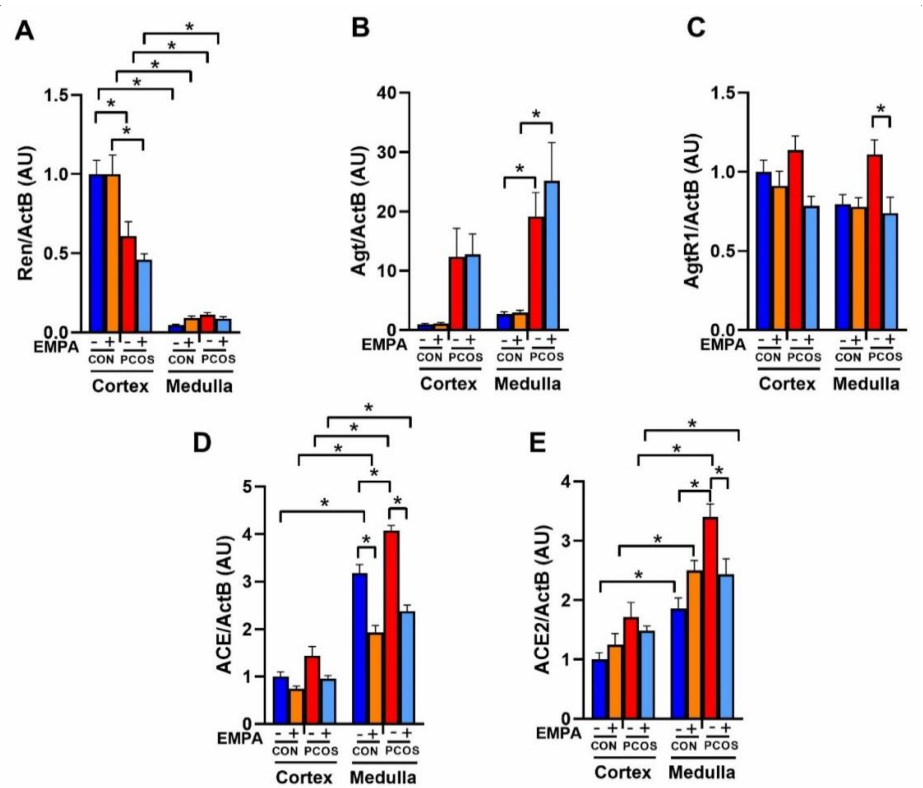
Figure 6. Effect of EMPA on mRNA expression of the intrarenal renin-angiotensin system in PCOS. Effect of EMPA on the renal cortical and medullar mRNA expression of ( A ) Ren (Renin), ( B ) Agt (Angiotensinogen), ( C ) AgtR1 (AT1R), and ( D ) ACE (angiotensin-converting enzyme), and ( E ) ACE2 (angiotensin-converting enzyme 2) after 3 weeks of EMPA treatment. Data are expressed as mean ± SEM. Data were analyzed by three-way ANOVA followed by Tukey post-hoc tests. Significant interaction was observed only for ACE2. * p < 0.05. n = 7–10 per